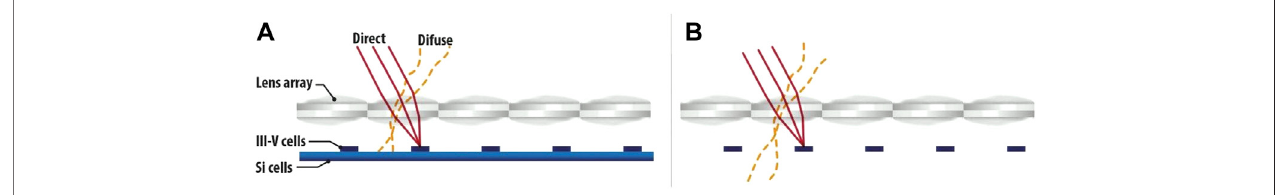
FIGURE3|(A) Inaddition tomicro-tracking, overallconversion rateisincreasedbyembedding diffuselightontoSicells(Askins etal.,2019). (B) Diffuselightbeing transmitted for daylight or agriculture applications (Nardin et al., 2020).